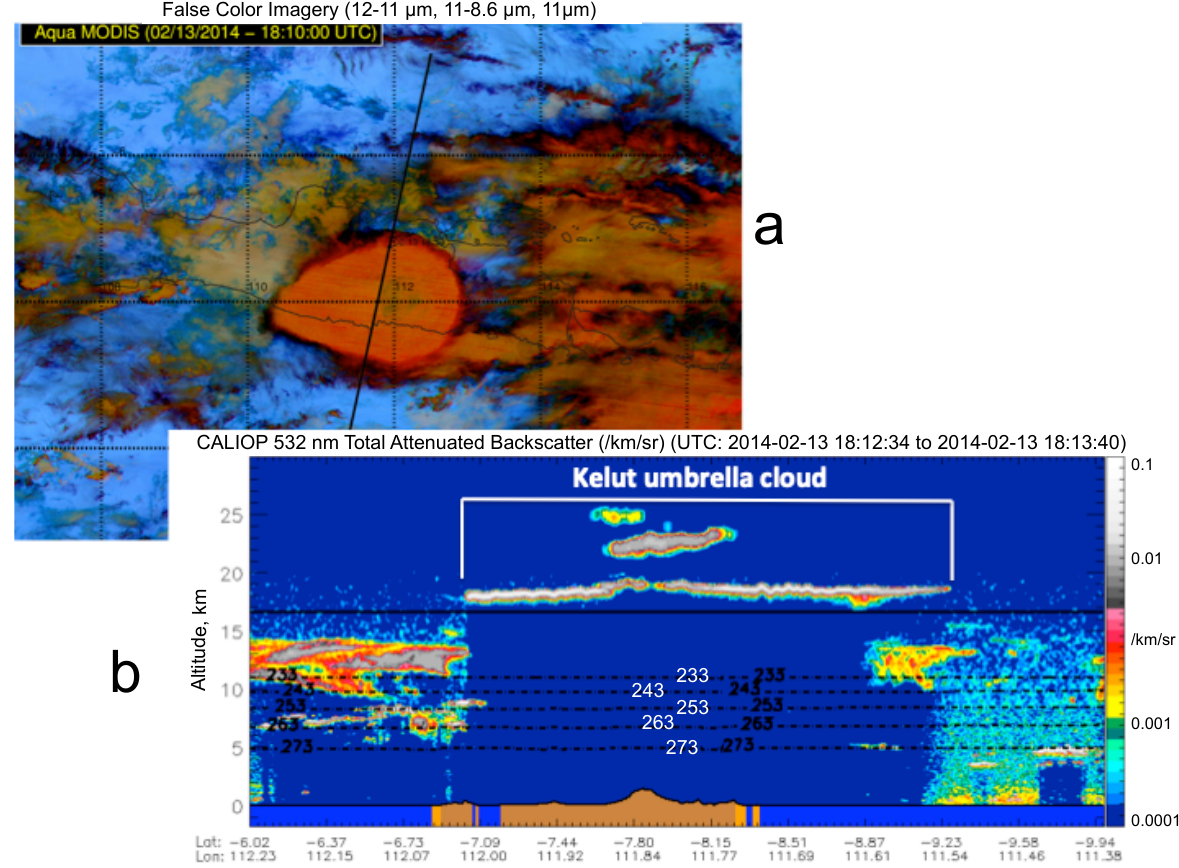
Figure 1. ( a ) Aqua-MODIS RGB false color image of Java, Indonesia, capturing the Kelut umbrella cloud on 13 February 2014 (red hues). ( b ) CALIOP nadir lidar total attenuated backscatter (along the track shown in ( a ) with a solid line) showing isotherms (kelvin, black dotted lines) and tropopause (black solid line). Clouds between 10–15 km on the South (right) side under the umbrella cloud could be of volcanic origin. Near-source, volcanic clouds occur as thick, concentrated layers of ash (note the attenuation of the signal below the umbrella